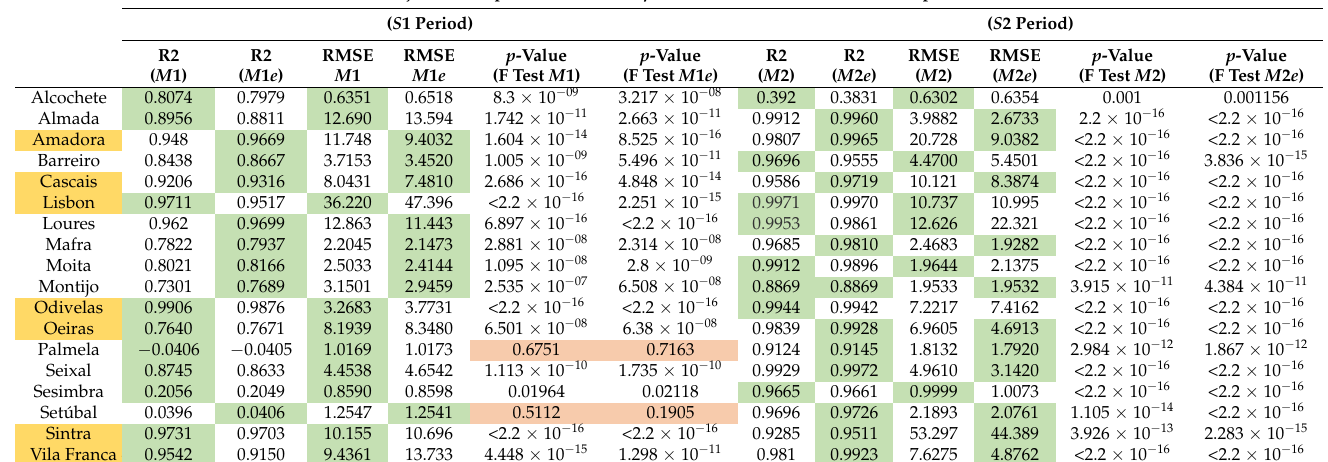
(1) Yellow color identifies the counties of Group 1. (2) Green color identifies the models with the best goodness- of-fit by the R 2 and RMSE criteria. (3) Red color identifies the counties in which the goodness-of-fit test is not significant at a significance level of 5%.